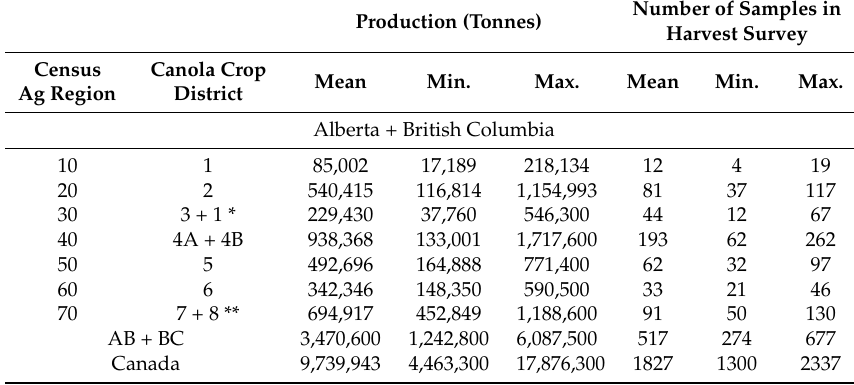
Number of Samples in Harvest